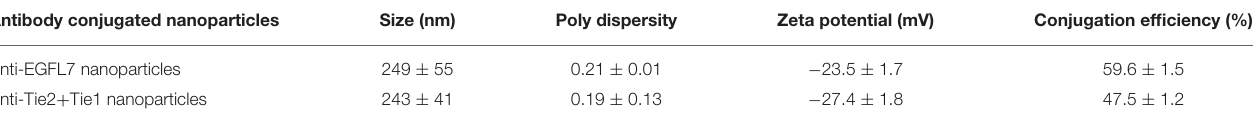
TABLE 2 | Endothelial cell targeted PLGA